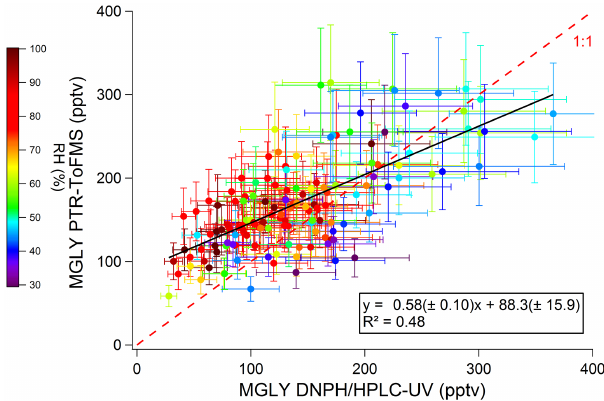
Figure 4. Scatter plot of MGLY concentrations measured by PTR- ToF-MS vs. concentrations measured by active sampling on DNPH cartridges. Black line and insert represent the linear regression. Sys- tematic errors associated with the PTR-ToF-MS (22%) and DNPH cartridge (25%) measurements are accounted for in the regression analysis. The scatter plot has been color coded according to the rel- ative